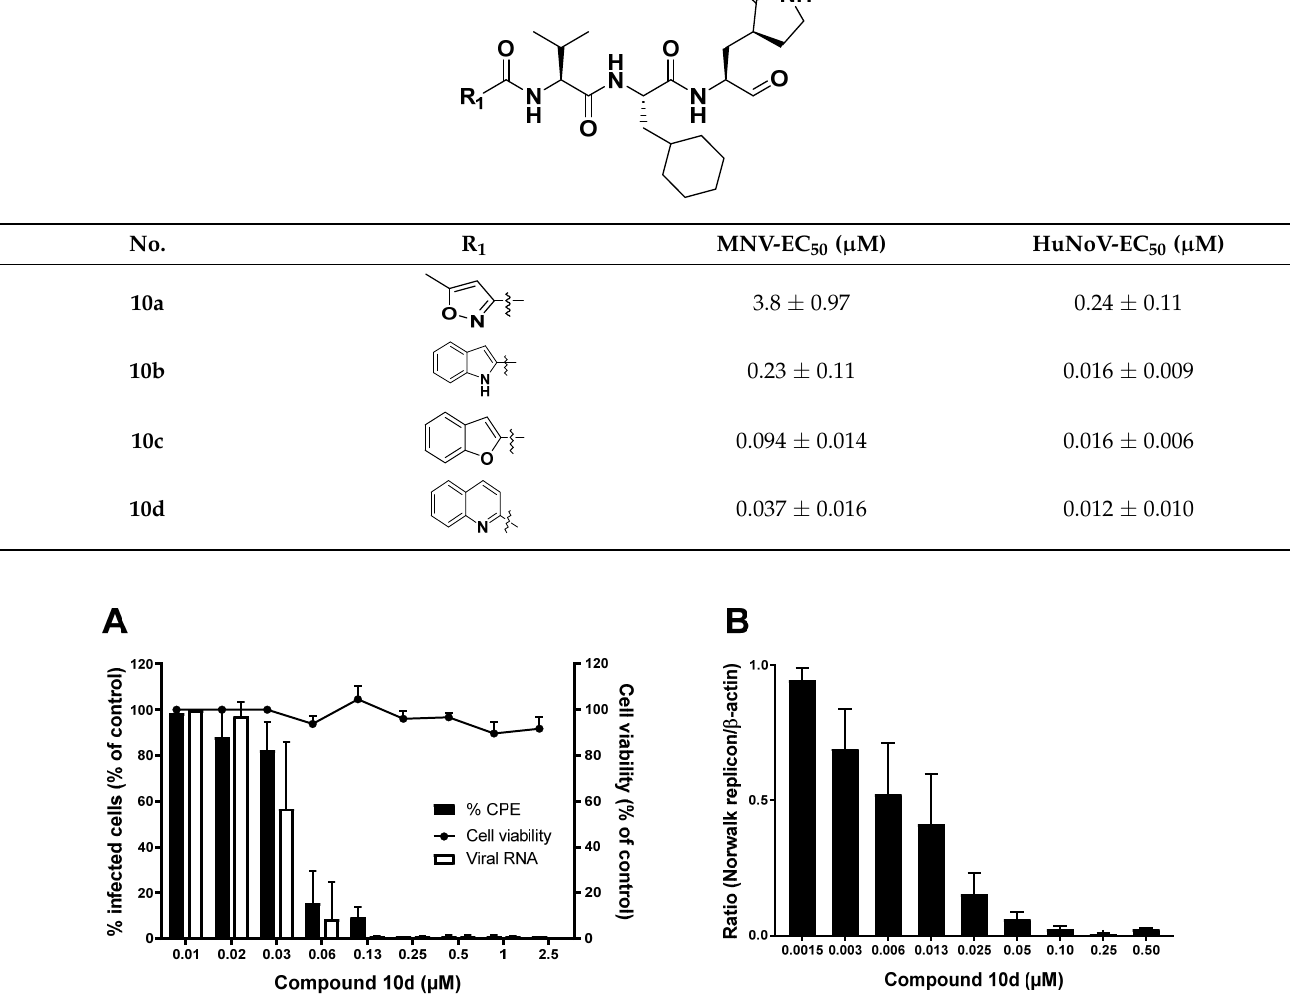
Table 2. Structures of tetrapeptide inhibitors with R 1 modifications and their antiviral activities against MNV and the HuNoV replicon.